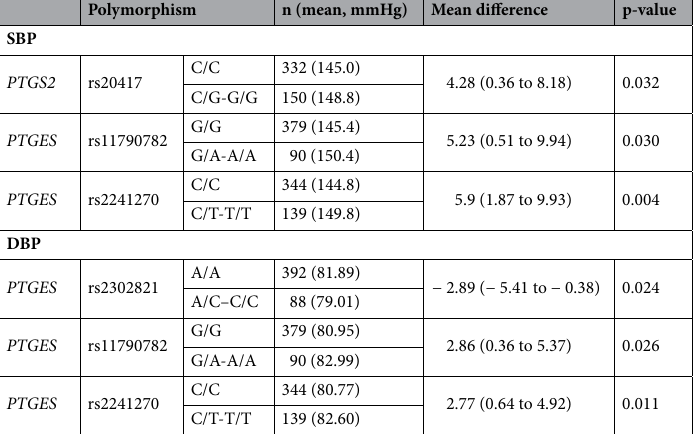
Table 3. Adjusted genetic association analysis with blood pressure in patients with nephrosclerosis. SBP systolic blood pressure, DBP diastolic blood